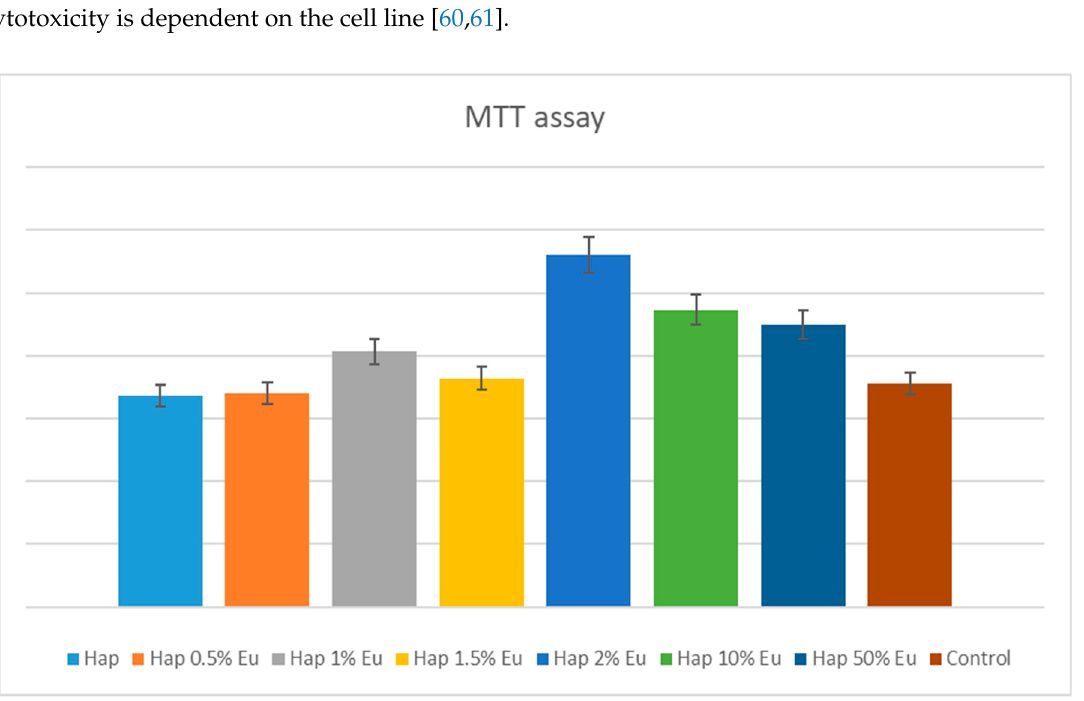
Figure 9. MTT assay showing the viability of AFSC in the presence of the Eu X HAp ceramic materials: HAp, Eu05HAp, Eu1HAp, Eu1.5HAp, Eu2HAp, Eu10HAp, Eu50HAp, and control (cell only).